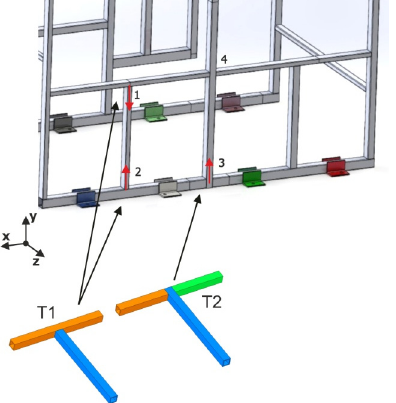
Figure 13. Equivalence of the complex structure joints to the T1 and T2 junctions.